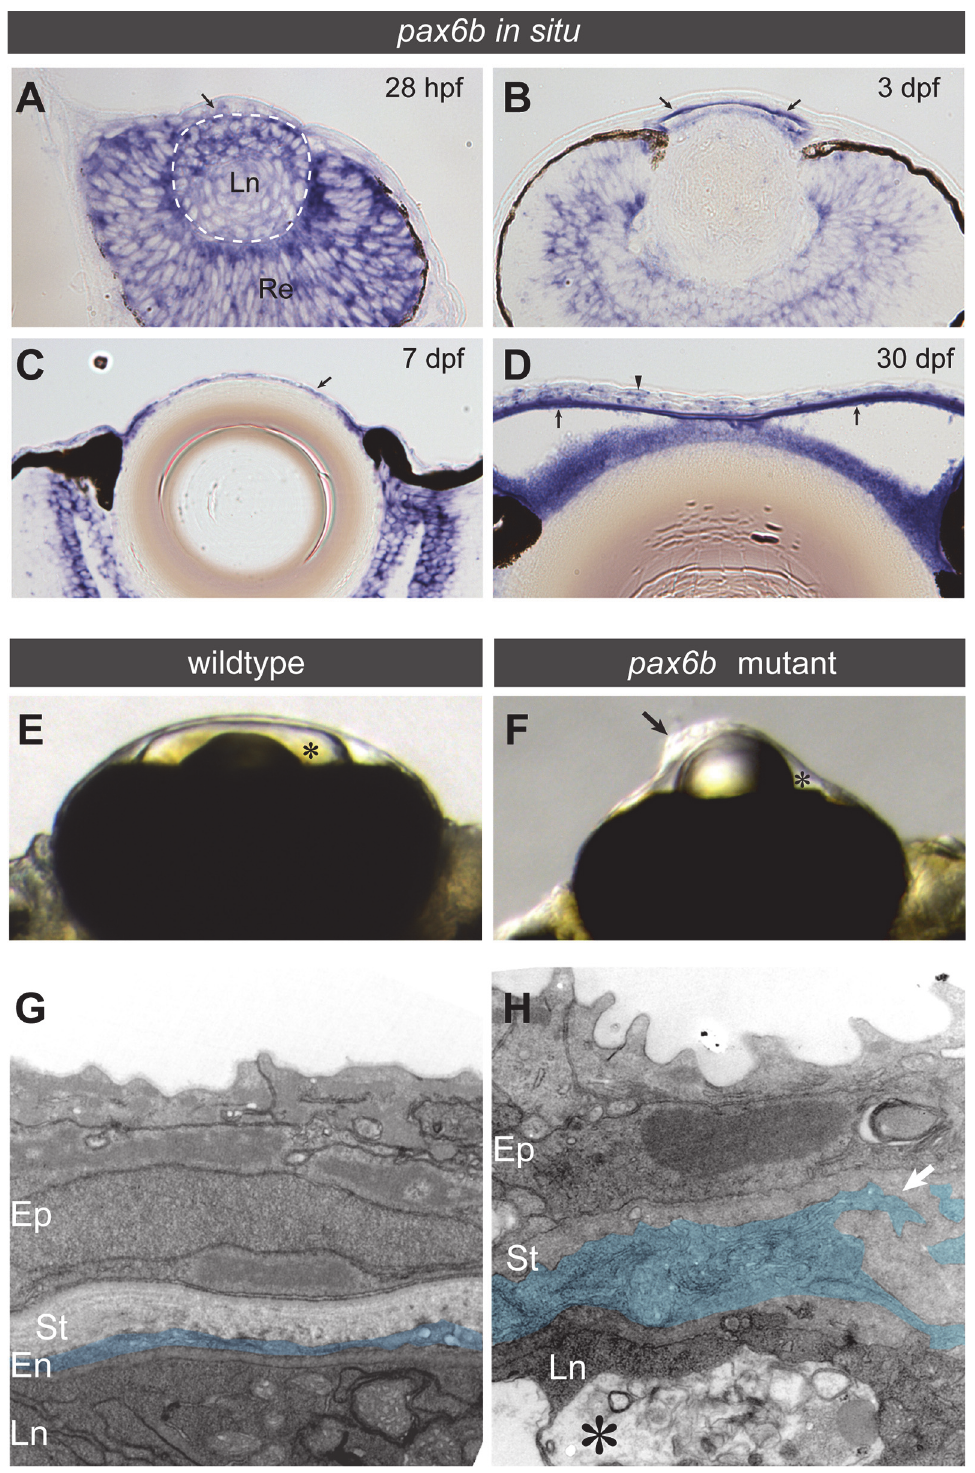
Fig 6. pax6b mutants ( also named sunrise ) present an abnormal anterior chamber with severe corneal endothelium defects. (A-D) pax6b in situ expression at 28 hpf (A), 3 dpf (B), 7 dpf (C) and 30 dpf (D). Transverse sections through the eye are shown with the ventral side left. (A) At 28 hpf, only a marginal level of pax6b transcripts is found in the ocular mesenchyme (arrow), well in contrast to high expression levels in the developing retina (Re) and the lens (Ln, stippled circle). (B-D) At 3 dpf, cells in the developing anterior chamber start to express pax6b (arrows in B), and its expression is maintained at 7